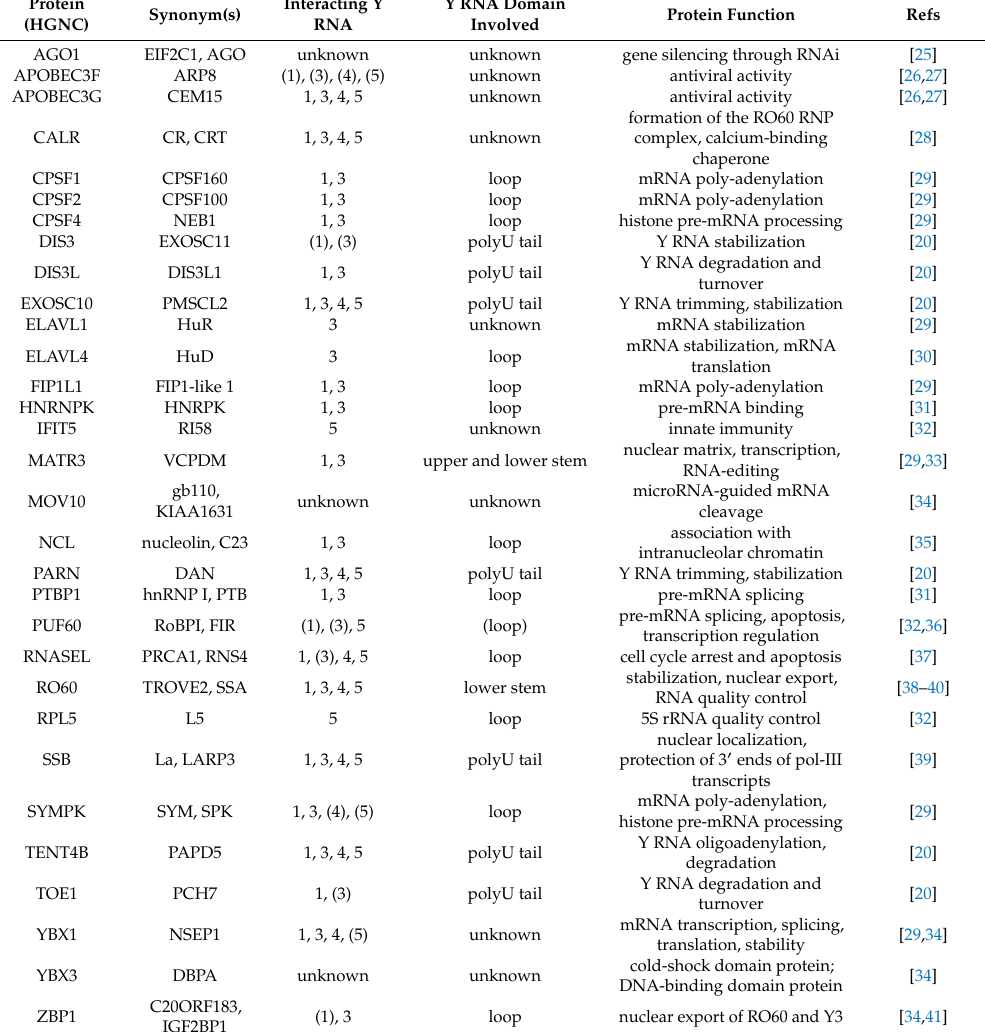
Table 1. Y RNA binding proteins. Data inside parentheses indicate unconfirmed data or minor e ff ects. Protein names (column 1) are those approved by the HUGO (Human Genome Organization) Gene Nomenclature Committee (HGNC). Proteins are listed in alphabetical order according to data in column 1. References (refs) indicate the works that illustrate the protein binding to Y RNA (i.e., not the protein function). Y RNA between parentheses indicate weak or unconfirmed data; 1-3-4-5 is for hY1-hY3-hY4-hY5,